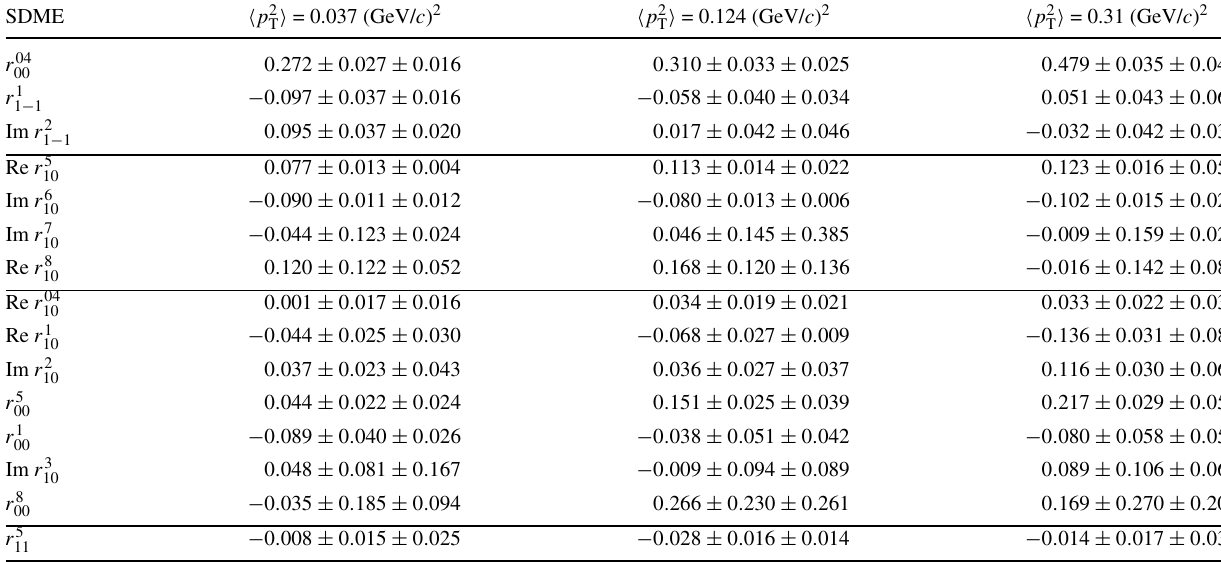
Table 6 The measured 23 unpolarised and polarised ω SDMEs in bins of p 2 statistical, the second